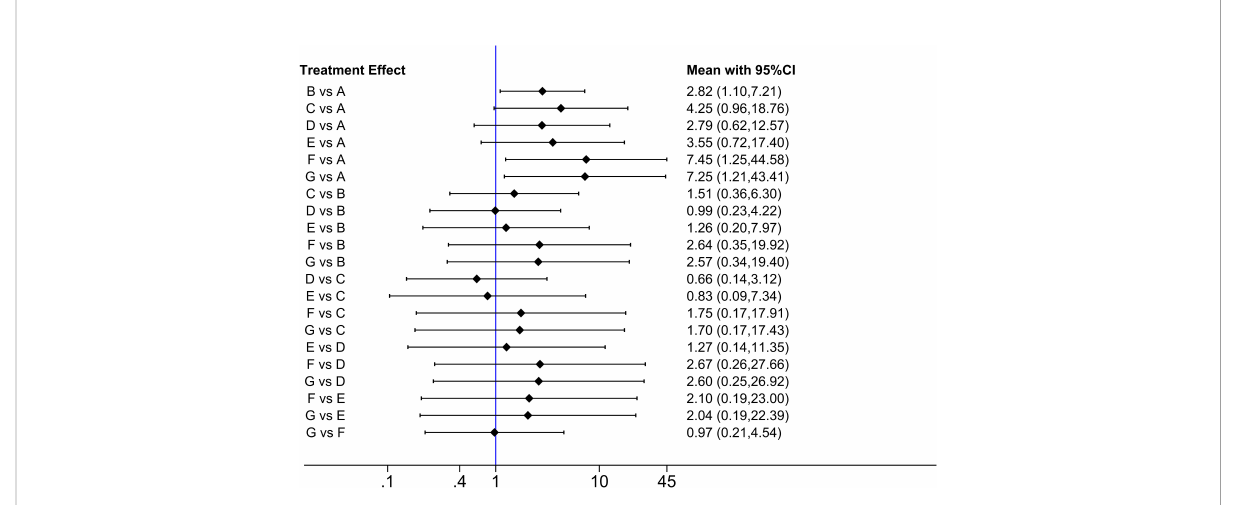
FIGURE 6 Meta-analysis forest plot. A: placebo; B: TNF- a Etanercept; C: IL-17A Secukinumab LD; D: IL-17A Secukinumab HD; E: IL-17A Ixekizumab; F: IL- 23 Ustekinumab LD; G: IL-23 Ustekinumab HD.